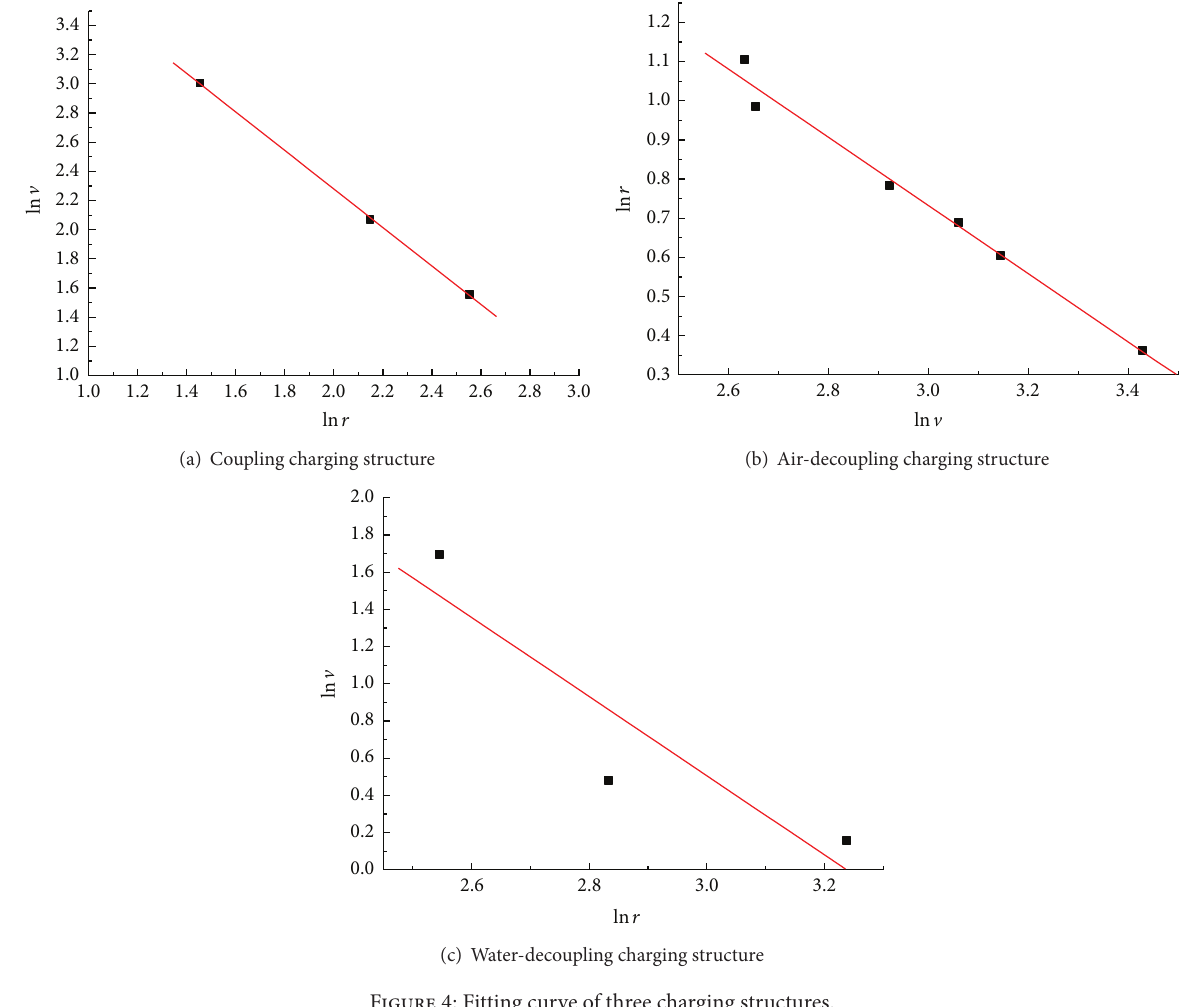
Figure 4: Fitting curve of three charging